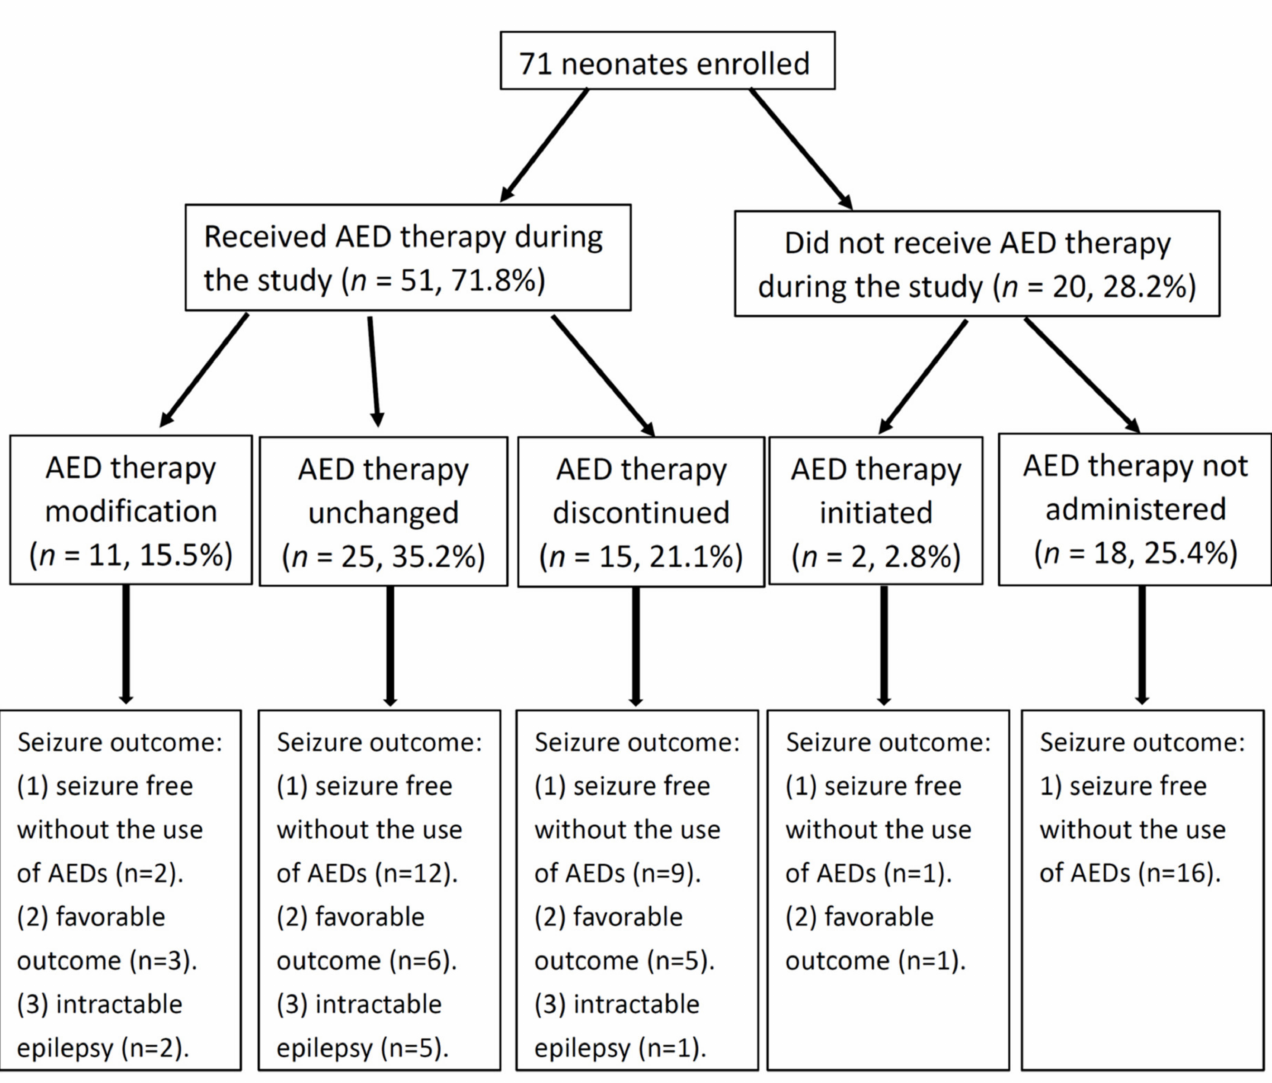
Figure 2. Impact of continuous video-EEG monitoring on clinical management. Fifty-one (71.8%) neonates had received an AED during the continuous video-EEG monitoring. Finally, continuous video-EEG monitoring led to a change in AED treatment in 39.4% of the neonates (28 of 71), in- cluding initiating AEDs (2, 2.8%), AED escalation (11, 15.5%), and AED discontinuation (15, 21.1%). Six neonates died during hospitalization, and 2 neonates died during the 1-year follow-up period. In terms of seizure outcome after 1-year follow-up in 63 neonates, 40 were seizure-free without the use of AEDs, 15 had a favorable outcome and 8 had intractable epilepsy. (AED: anti-epileptic